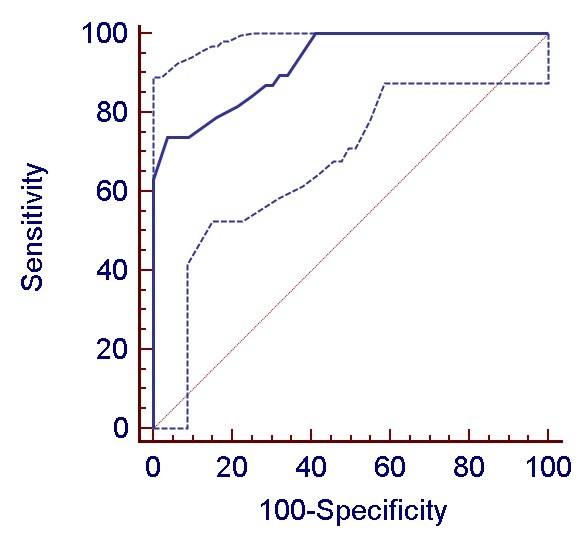
Receiver operating characteristic (ROC) curves assessing the association of transmitral propagation velocities (Vp) with post-cardiopulmonary bypass left ventricular dysfunction (mean and 95% coinfidence limits).